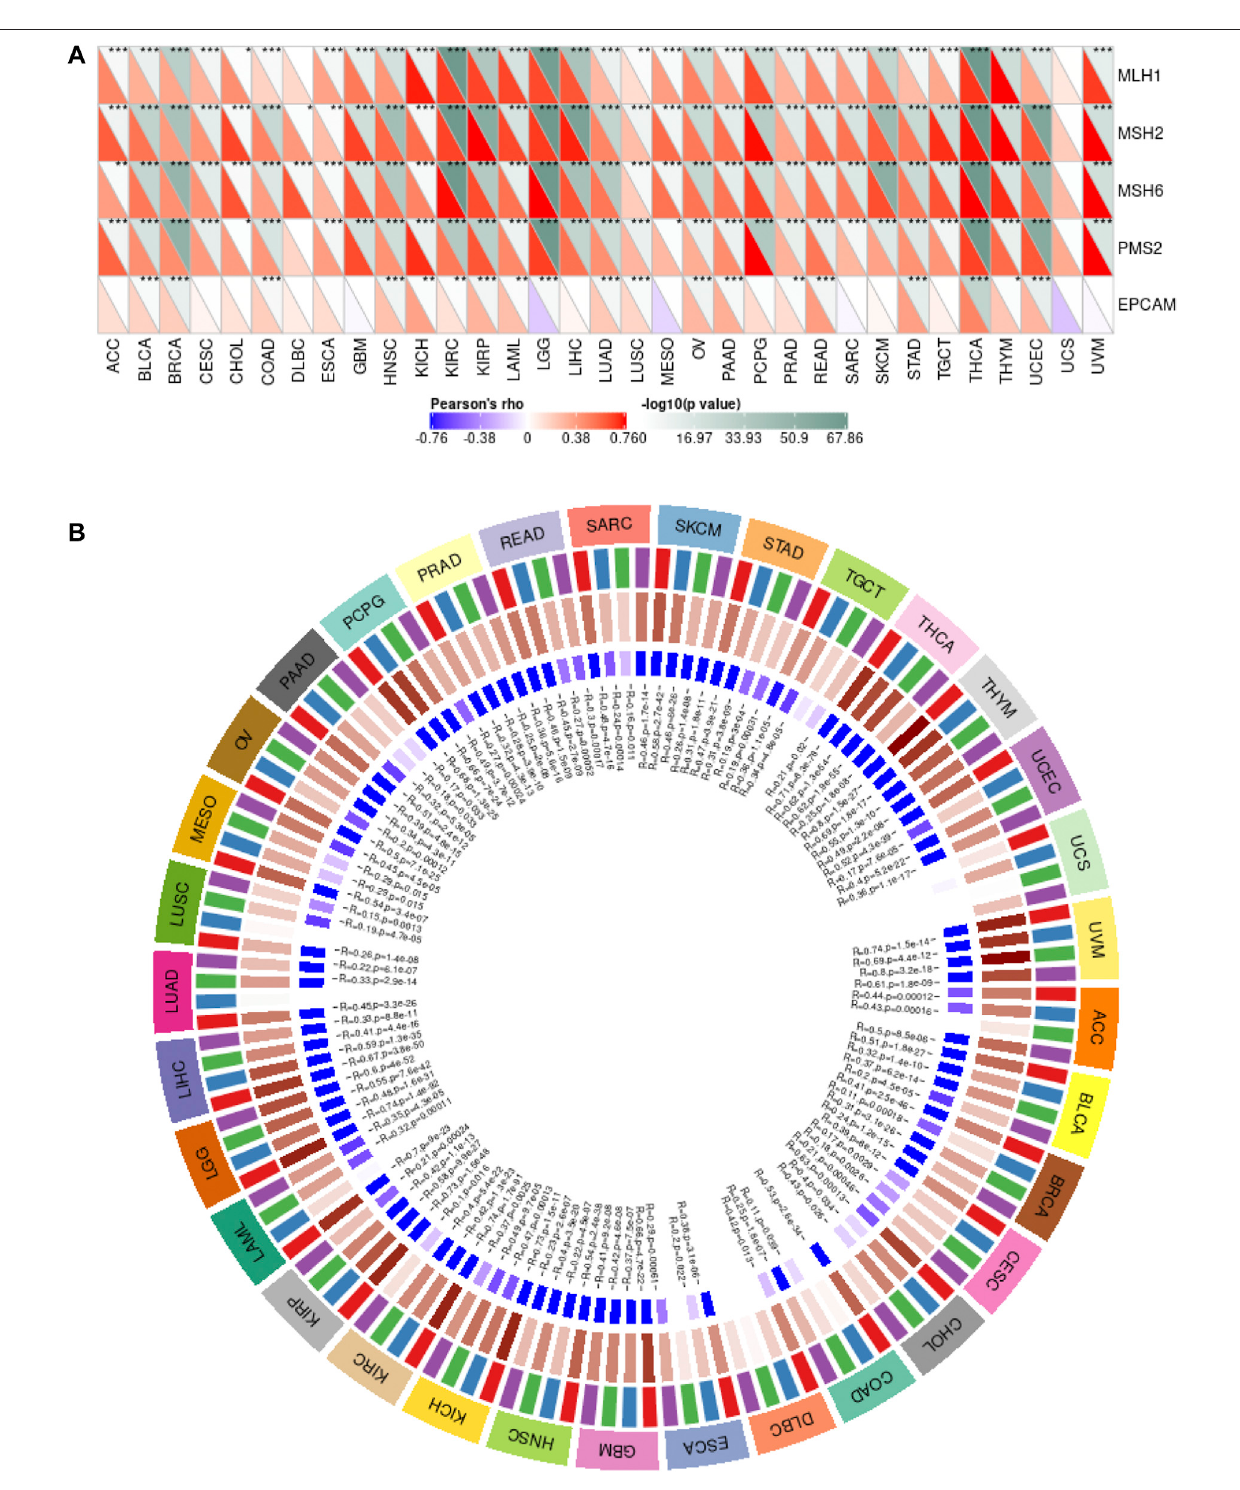
FIGURE 4 | CSTF2 is involved in DNA mismatch repair and methylation in pan-cancer. (A) Correlation between MMR genes and CSTF2 in endemic cancers. (B) Correlation between CSTF2 expression and methyltransferase in endemic carcinomas (red:DNMT1, blue:DNMT2, green:DNMT3A, purple:DNMT3B).